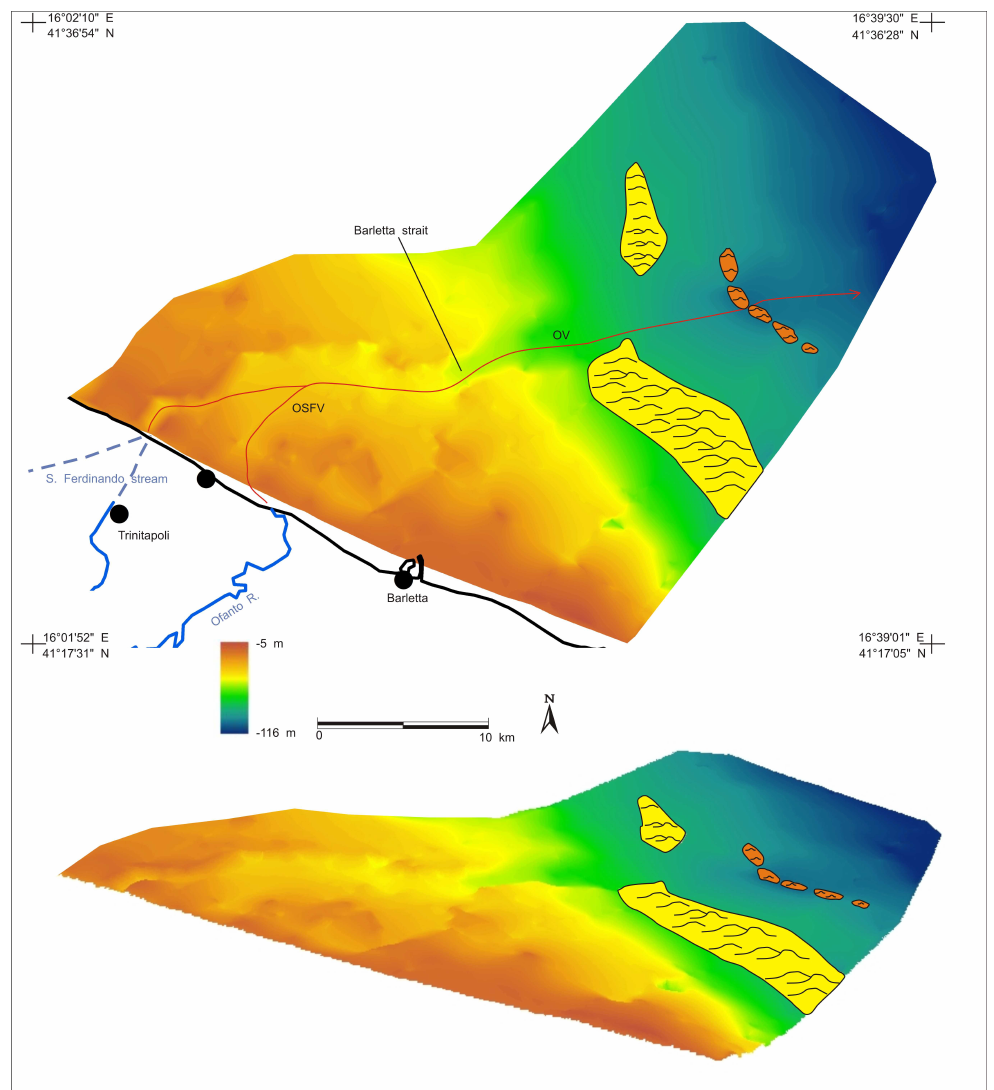
Figure 2. Digital Elevation Model (DEM) of the erosional surface (ES1) around the Ofanto valley both in plan view ( up ) and in oblique view ( down ). In orange and yellow with mounded morphologies drawn, the extension of facies 2 bodies into dune-like / barrier morphology of unit A l and B m , respectively. Overall, the incision connected to the Ofanto River cuts the ES1 surface (Figure 2) and, on its landward side, it appears as two di ff erent subincisions. These subincisions merge in a single wide and shallow valley (OSFV). The OSFV reaches a maximum width of 11.9 km and narrows to ca. 2.5 km at the Barletta strait [27]. The OSFV reaches depths between ca. − 15 m and ca. − 50 m b.s.l. at the Barletta strait. With respect to the surrounding ES1, the valley shows decreasing depths toward the open sea, between ca. 17 m and less than 10 m. Outside the Barletta strait, the valley widens again without reaching the width of the OSFV, and since the incision is due only to the Ofanto River, we call this valley reach the Ofanto valley (hereinafter OV). The OV turns clearly toward the ENE; in this middle-distal sector, the valley reaches a maximum depth of ca. 14 m (profile T3, Figure 3)